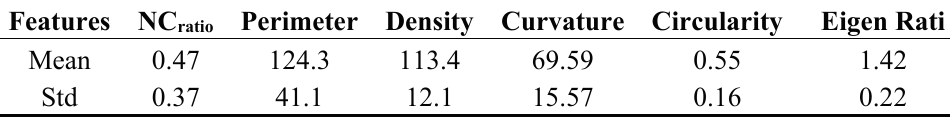
Table 4. Mean and standard deviation for the malignant sputum cell.